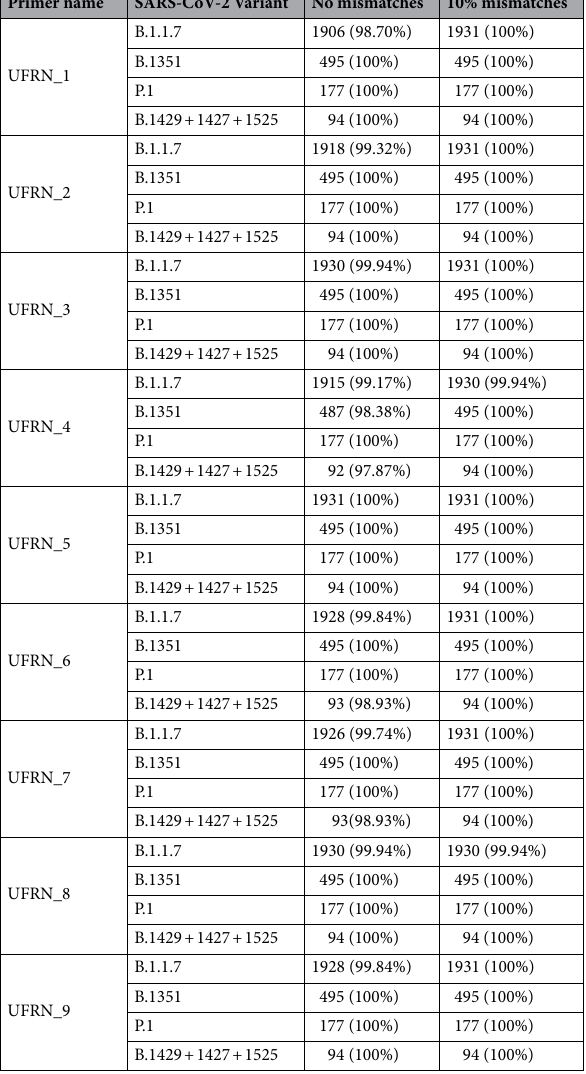
Table 3. Analysis of potential annealing (In silico PCR) of UFRN primers (UFRN_primers) to the genomes of the main SARS-CoV-2 variants. The percentage of the total number of sequences that annel without mismatches or allowing 10% mismatches are shown in parentheses. No mis number of sequences that anneal to the primer without mismatches; 10% mis number of sequences that anneal to the primer allowing 10%